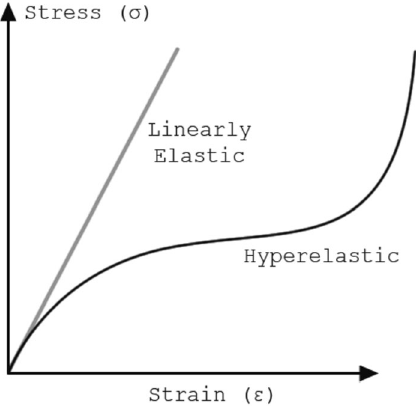
Fig. 3 The difference between the behavior of the elastic and the hyper-elastic